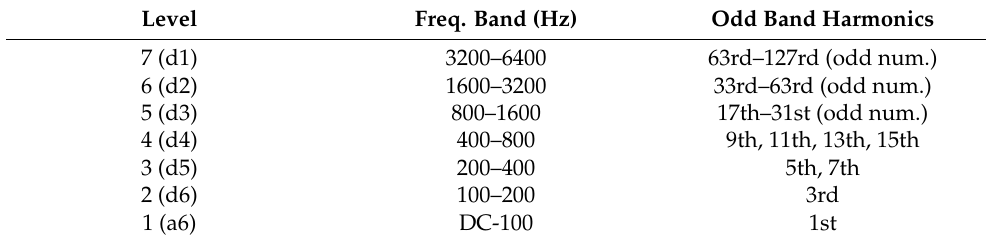
Table 3. Frequency bands and harmonics of six levels of the Discrete Wavelet Transform (DWT). Level